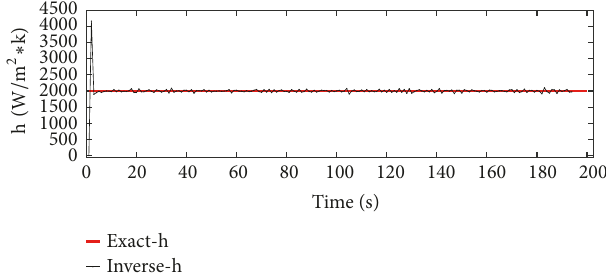
Figure 14: The heat transfer coefficient of the measuring point at the boundary 𝐿 = 0.004𝑚 .